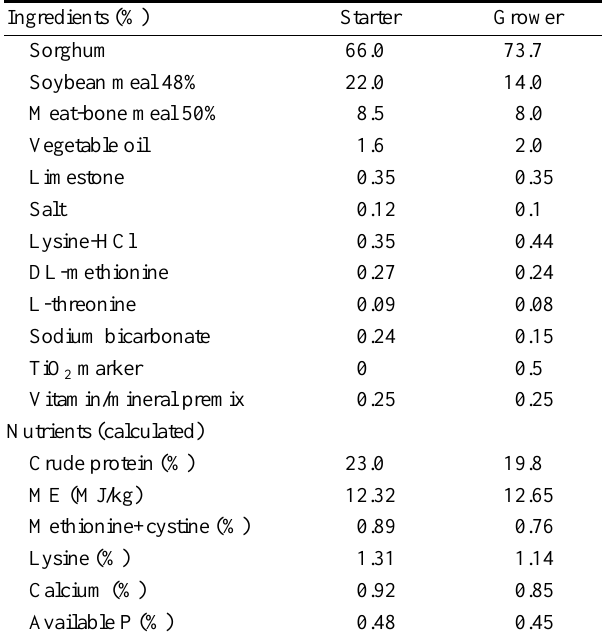
Table 1. Broiler starter and grower diet